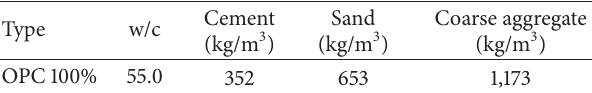
Table 8: Mix proportions for verification (field investigation).